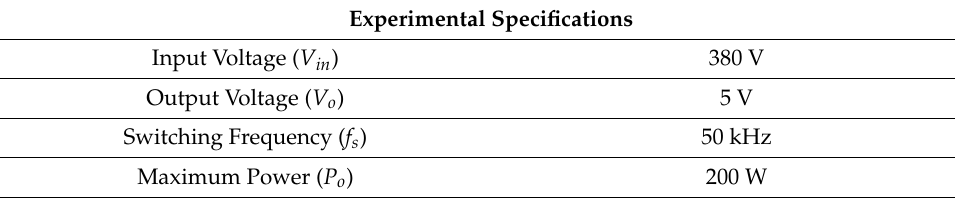
Table 1. Prototype specification of the proposed